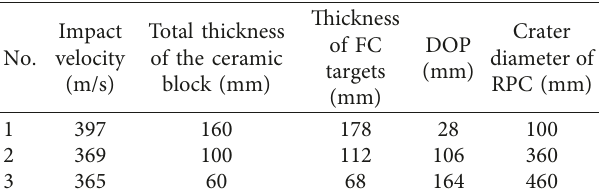
Table 9: Experimental results.